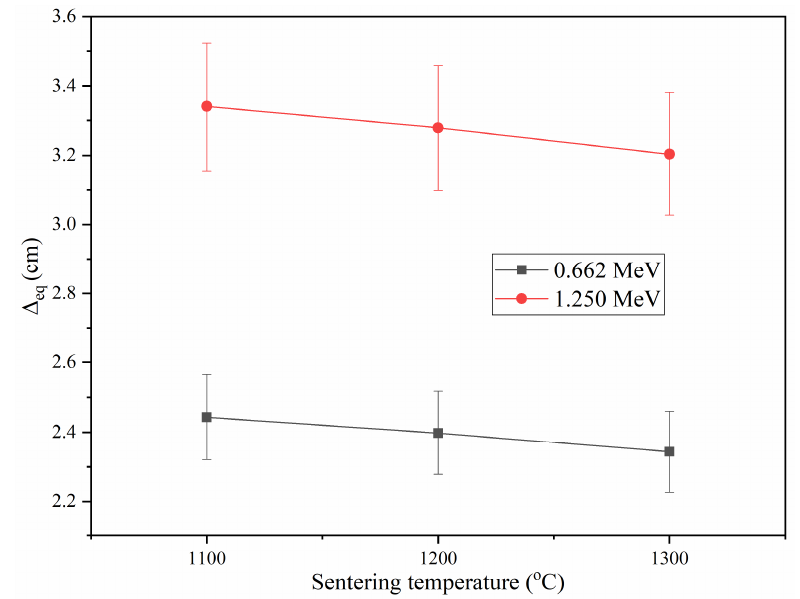
Figure 5. Effect of sintering temperature on the half value thickness ∆ 0.5 of the fabricated ceramic samples.